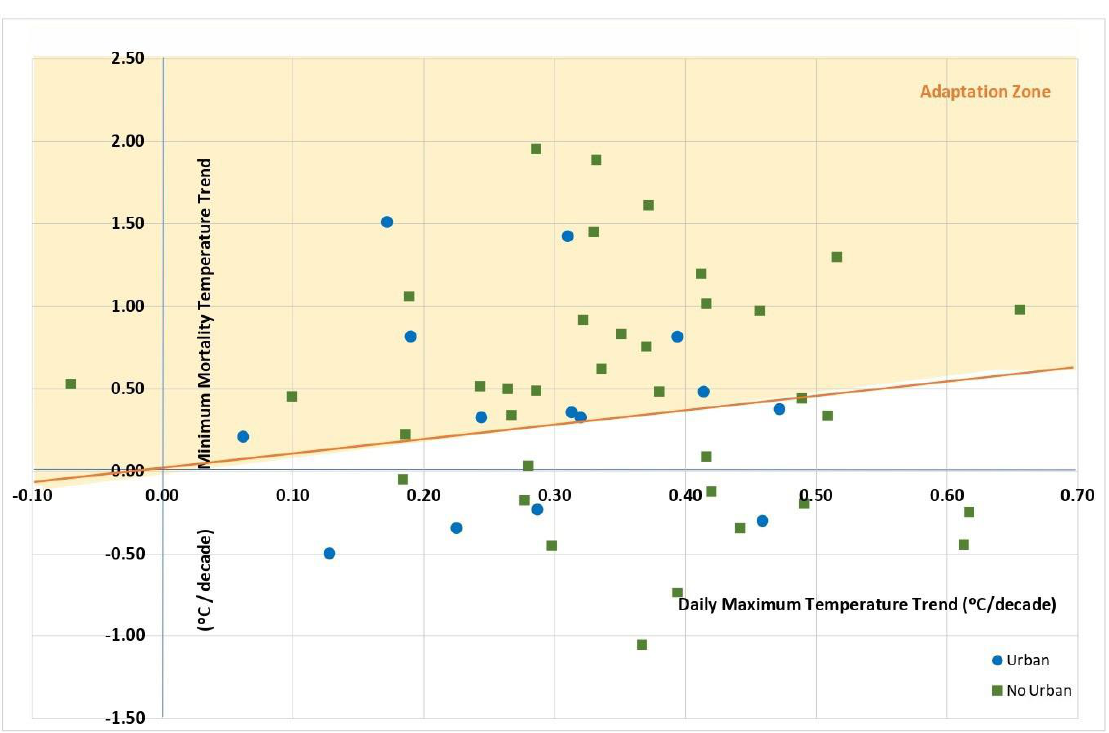
Figure 3. Scatter plot of the minimum mortality temperature with respect to variations in maximum daily temperatures, by territory in Spain (1983 – 2018). The shaded area indicates provinces showing adaptation to heat.